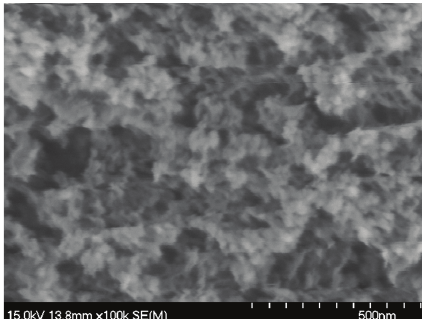
Figure 4: SEM micrograph of silica aerogel.